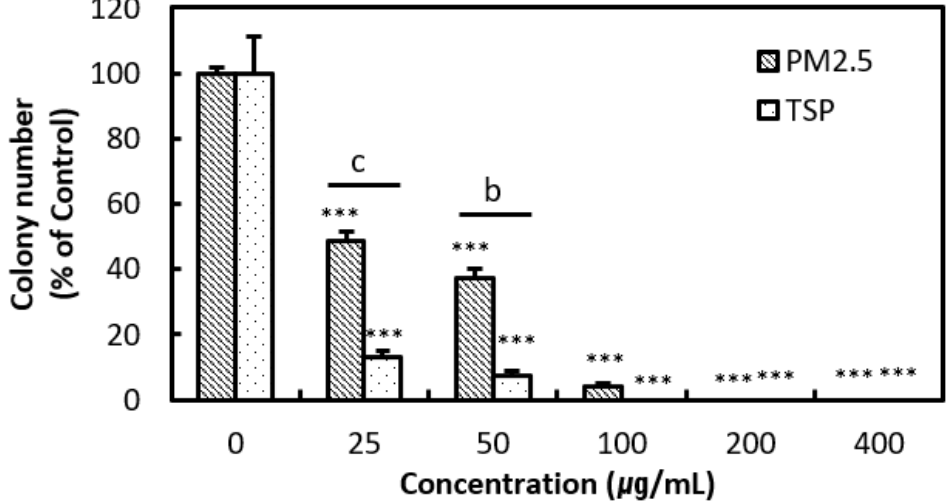
Figure 5. The inhibition of cell colony formation induced by PM2.5 and TSP in human lung epithelial cells (A549). Cells were exposed to PM2.5 and TSP at concentrations of 0, 25, 50, 100, 200, and 400 µg/mL for 10 days. Experiments were repeated thrice. The values are reported as the mean ± SD (Student’s t -test, *** p < 0.001, vs. control; b p < 0.01, c p < 0.001).